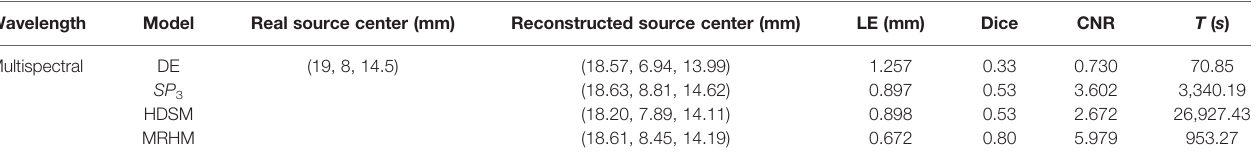
TABLE 4 | Quantitative results in multispectral reconstruction experiment.